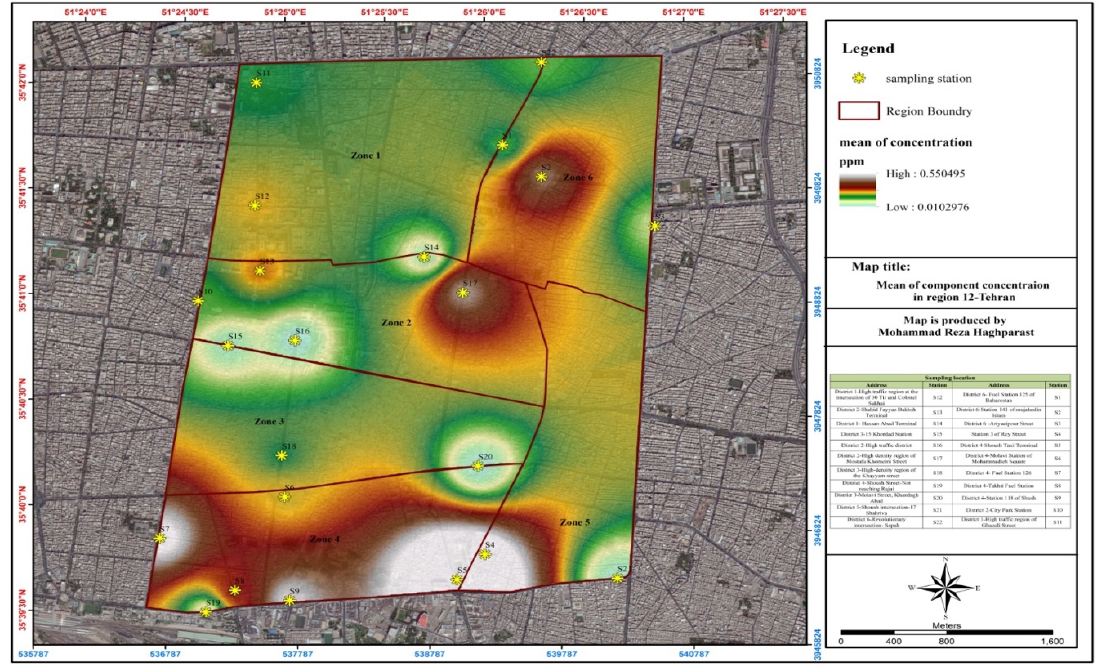
Figure 12. Mean of total component concentration in the region on January,